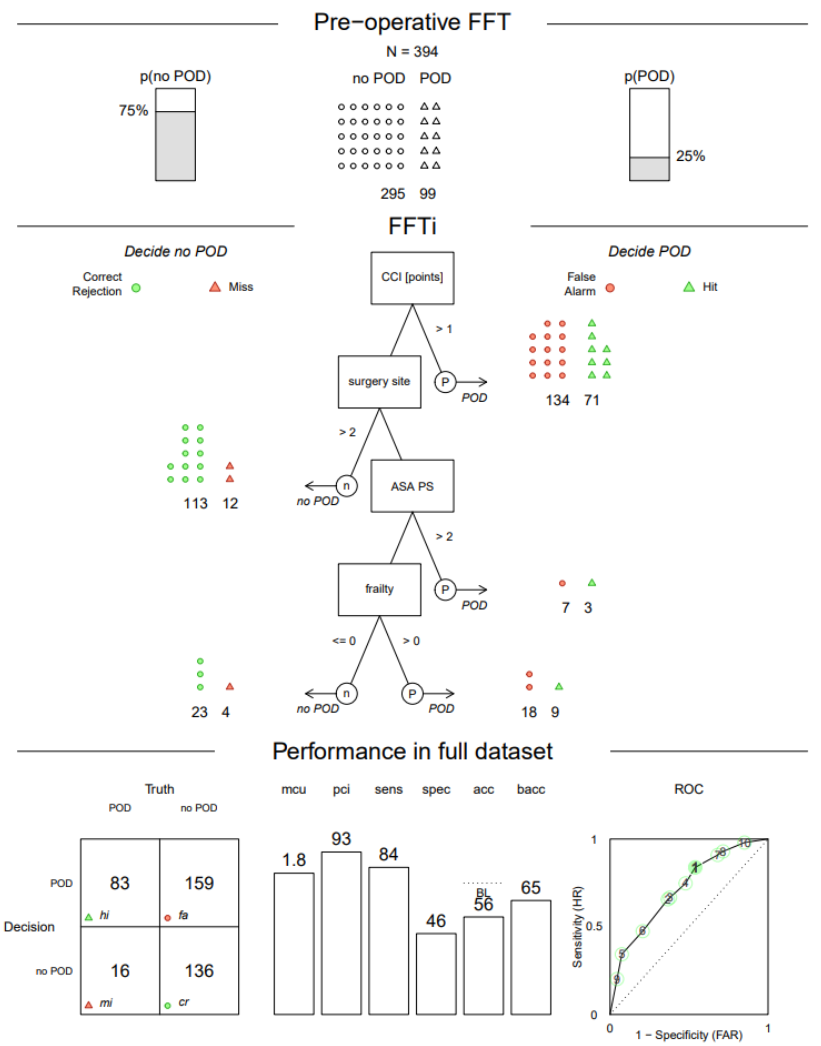
Figure 4. Pre-operative fast-and-frugal tree estimated with the ifan algorithm. POD — postoperative delirium, p(POD) — probability of POD a priori (base rate), p (no POD) — complement of p(POD), FFTi — fast-and-frugal tree construction using the ifan algorithm, CCI — Charlson Comorbidity In- dex, surgery site > 2 — peripheral, ASA PS — physical status according to the American Society of Anesthesiologists, frailty <= 0 — robust, frailty > 0 — pre-frail/frail, mcu — mean cues used, pci — per- cent cues ignored, sens — sensitivity, spec — specificity, acc — unweighted accuracy, back — balanced